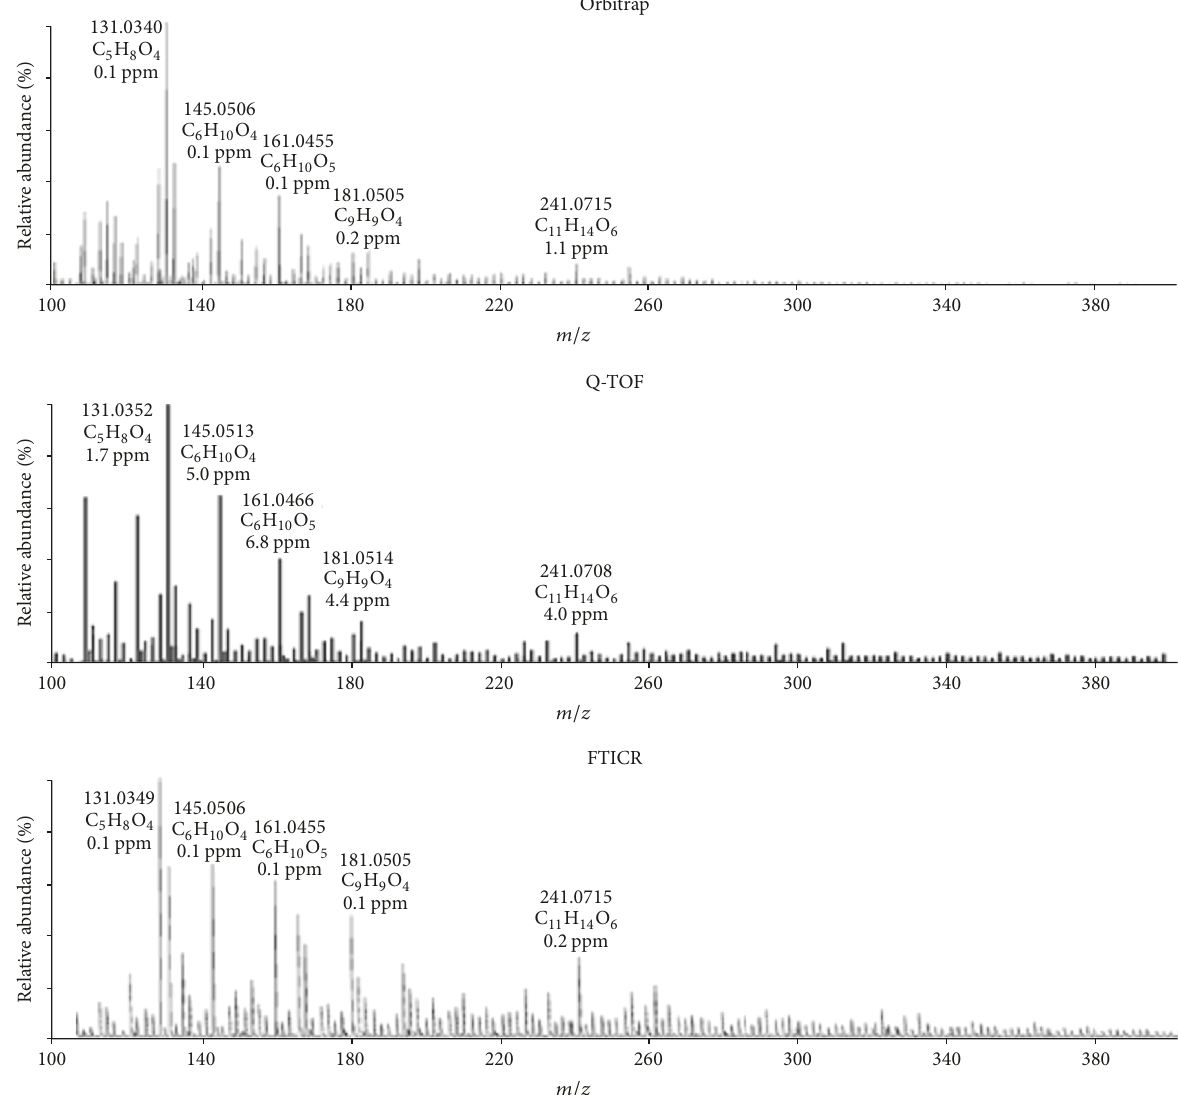
Figure 7: High resolution mass spectra (negative ESI source) of red oak biooils obtained using Orbitrap, Q-TOF, and FT-ICR, respectively